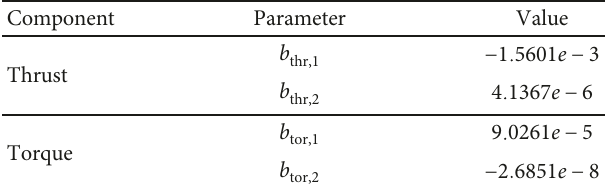
Table 2: Coe ffi cients of the rotor component by